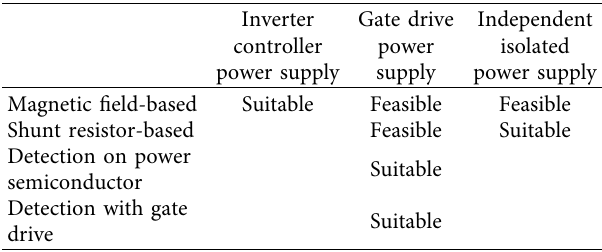
Table 2: Power supply solutions for the over-current detection methods.